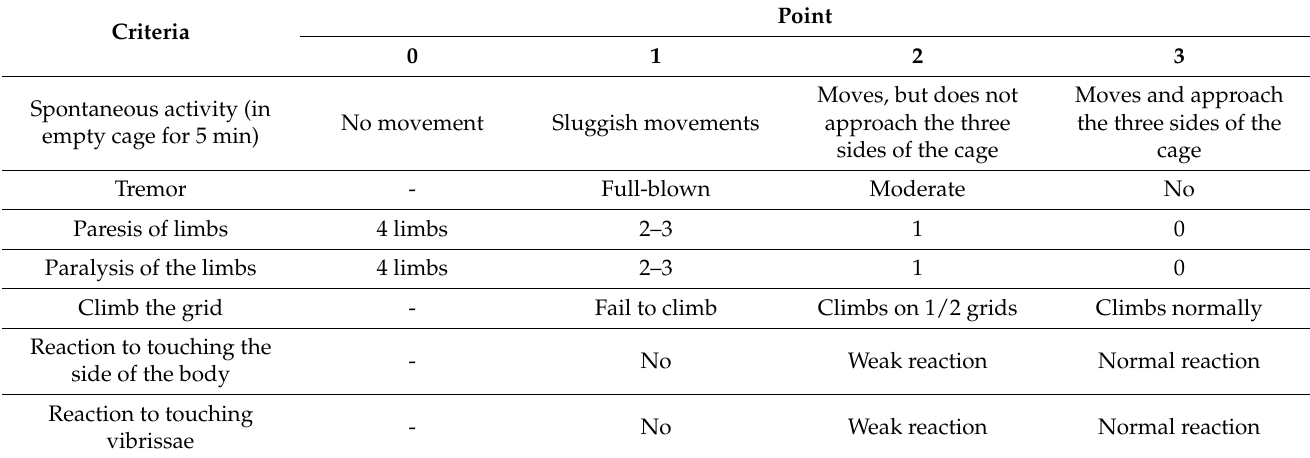
Table 1. The neurological deficit assessment scale for meningitis and